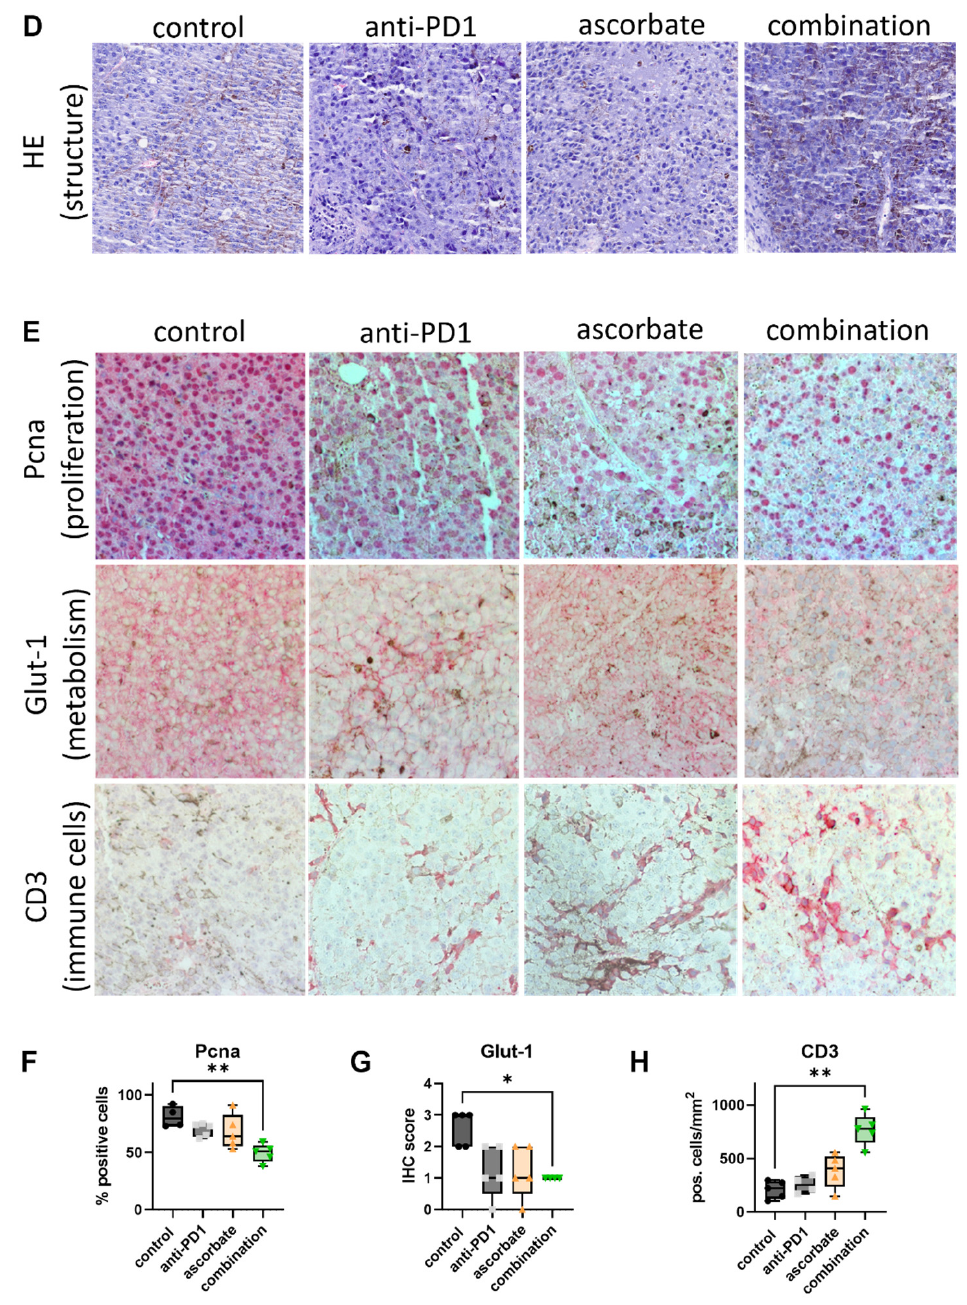
Figure 5. Effects of treatment with ascorbate and/or anti − PD1 on mouse organs and tumors. ( A ) H&E staining of lung, liver, gut, kidney, and spleen from animals after treatment either with ascorbate (3 g/kg i.p., daily), anti − PD1 (2 mg/kg i.p., twice per week), or the combination of ascorbate and anti − PD1. ( B ) Weight progression curves of animals treated with ascorbate (3 g/kg i.p., daily), anti − PD1 (2 mg/kg i.p., twice per week), or the combination of ascorbate and anti − PD1. ( C ) Percentage change in mouse weight during the experimental procedure. ( D ) H&E staining of the tumors of the groups treated with ascorbate (3 g/kg i.p., daily), anti − PD1 (2 mg/kg i.p., twice per week), or the combination of both. ( E ) Immunohistochemical tumor staining for Pcna, Glut − 1, and CD3 after treatment with ascorbate (3 g/kg i.p., daily), anti − PD1 (2 mg/kg i.p., twice per week), or the combination of ascorbate and anti − PD1. Representative images are shown at 200× magnification. ( F ) Quantification of Pcna from tumors treated with ascorbate (3 g/kg i.p., daily), anti − PD1 (2 mg/kg i.p., twice per week), and the combination of both ( n = 5 in every group). Displayed are the percentages of positive cells. ( G ) Quantification of Glut − 1 from tumors treated with ascorbate (3 g/kg i.p., daily), anti − PD1 (2 mg/kg i.p., twice per week), and the combination of both ( n = 5 in every group, except the combination which represents n = 4). Displayed is the IHC score. ( H ) Quantification of CD3-positive cells in tumors treated with ascorbate (3 g/kg i.p., daily), anti − PD1